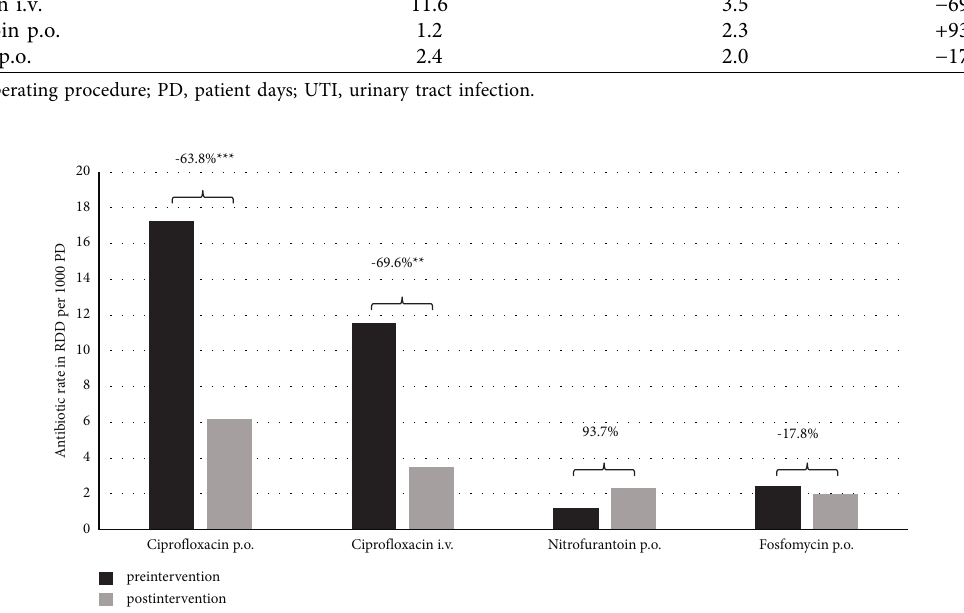
Figure 1: Antibiotic consumption of ciprofloxacin, fosfomycin, and nitrofurantoin. RDD, recommended daily doses; PD, patient days. ∗ Statistical significance, ∗∗∗ p < 0.001, ∗∗ p <